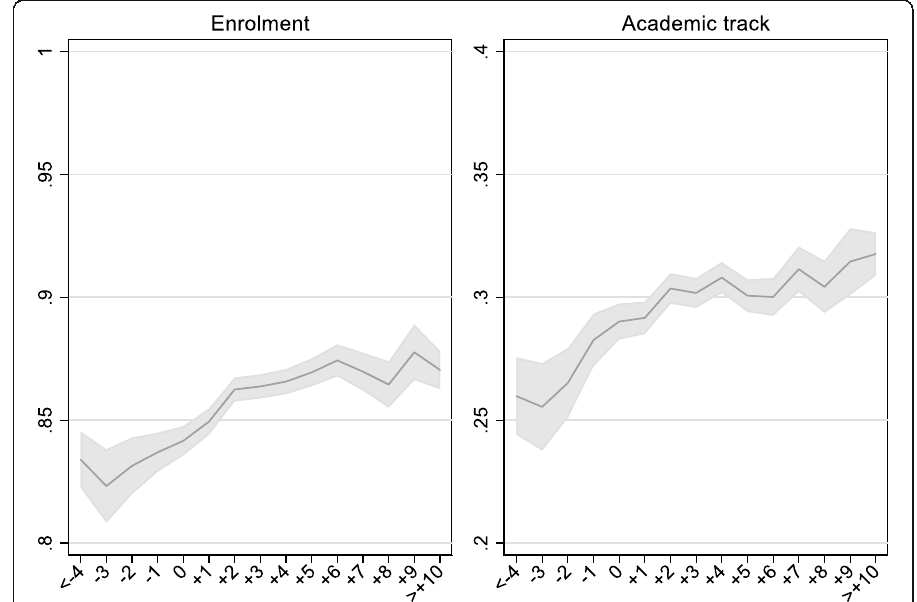
Fig. 7 Parental age difference (father-mother) and probabilities of being enrolled in a 5-year upper- secondary school and in the academic track. Figures show the average linear predictions (with 95% confidence intervals), from linear probability models with robust standard errors. Models control for both parents ’ social class and education, maternal age at birth, region of residence, trimester-year of